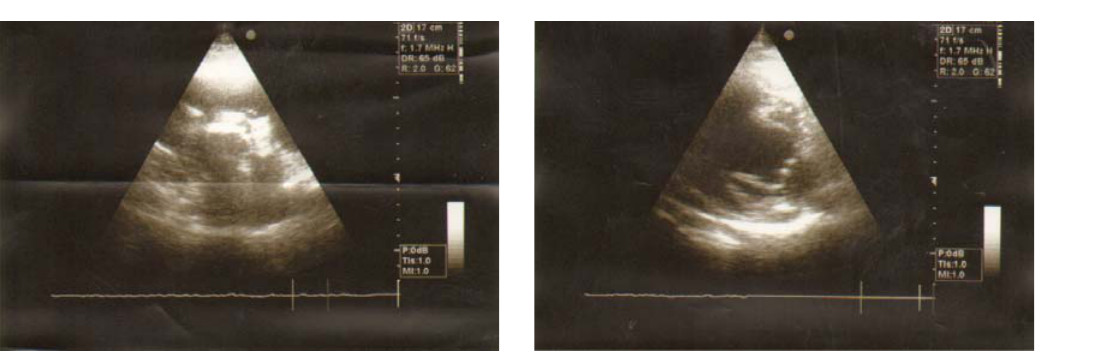
FIGURE 1. TTE: Suspected aortic abscessus formation FIGURE 2. TTE: Postin fl ammatory mitral valve changes